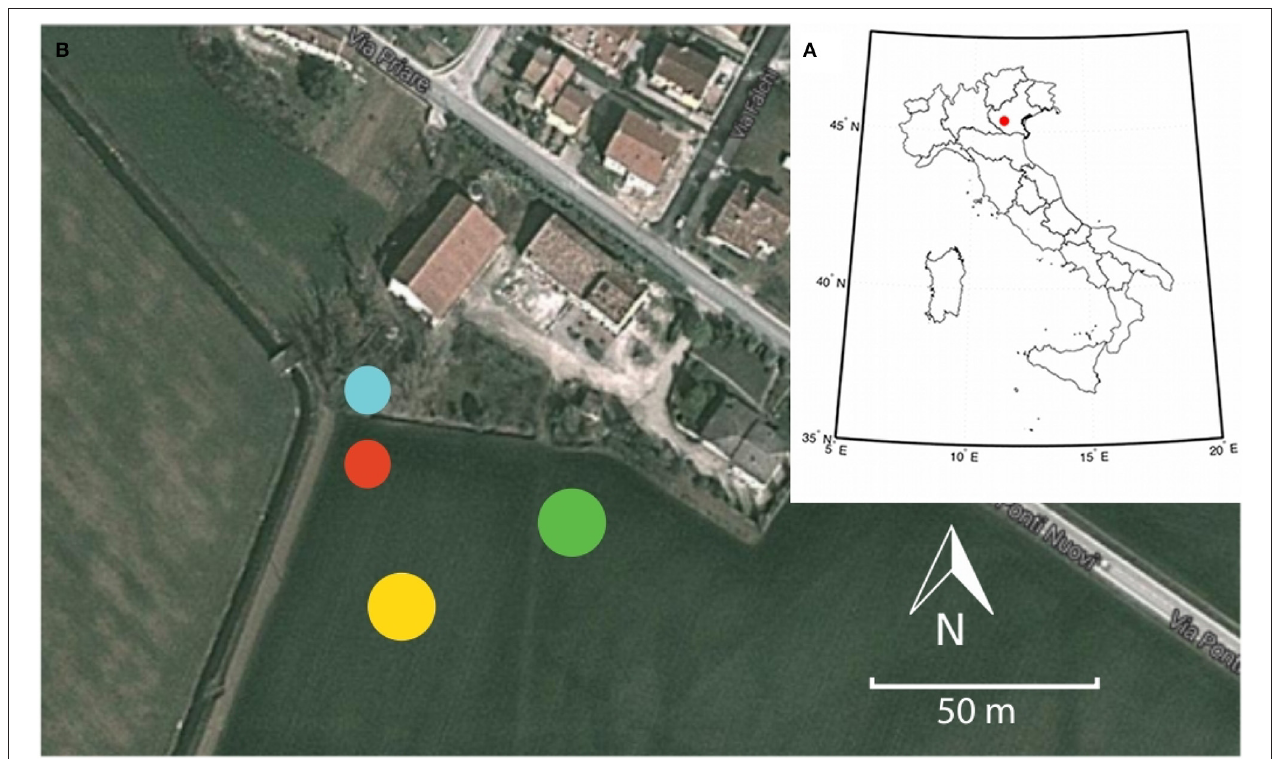
FIGURE 1 | (A) Location of the study area within Italy. (B) Position of the TDR probes in the uninformed site (yellow dot) and in the informed site (green dot), TDR data logger (blue dot), and rain gauge (red dot).